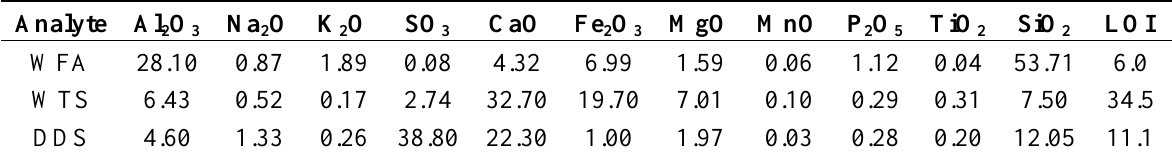
Table 2. Waste samples chemical compositions, wt %.